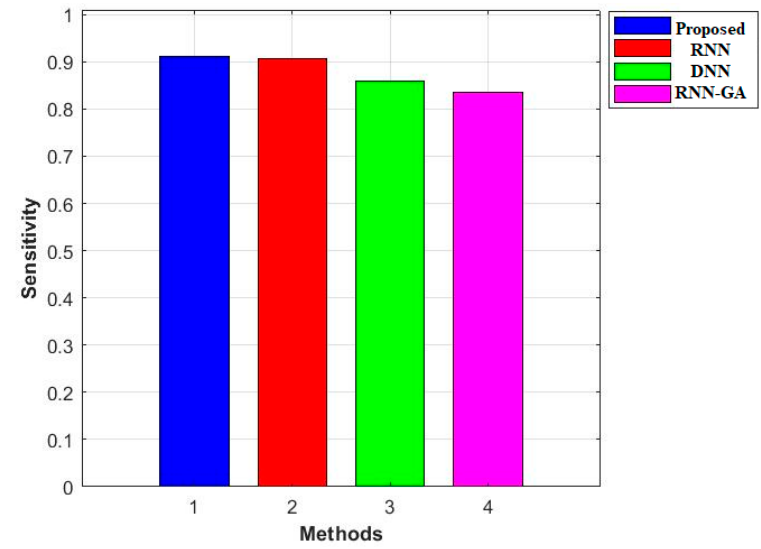
Figure 12. Sensitivity performance of confusion matrix.